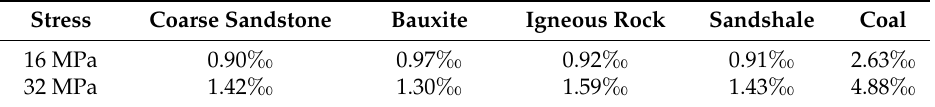
Table 1. Different specimens unloading dilatation coefficients in the